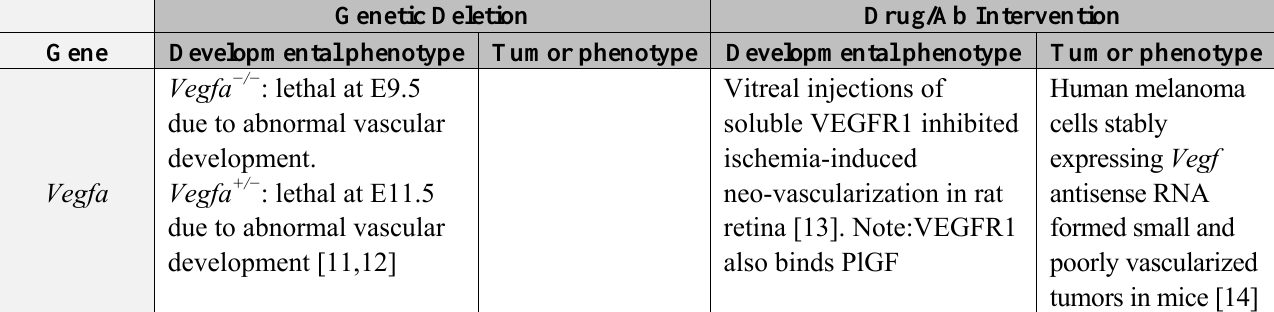
Table 1. Comparison of vascular phenotypes in development and cancer following gene modifications or drug